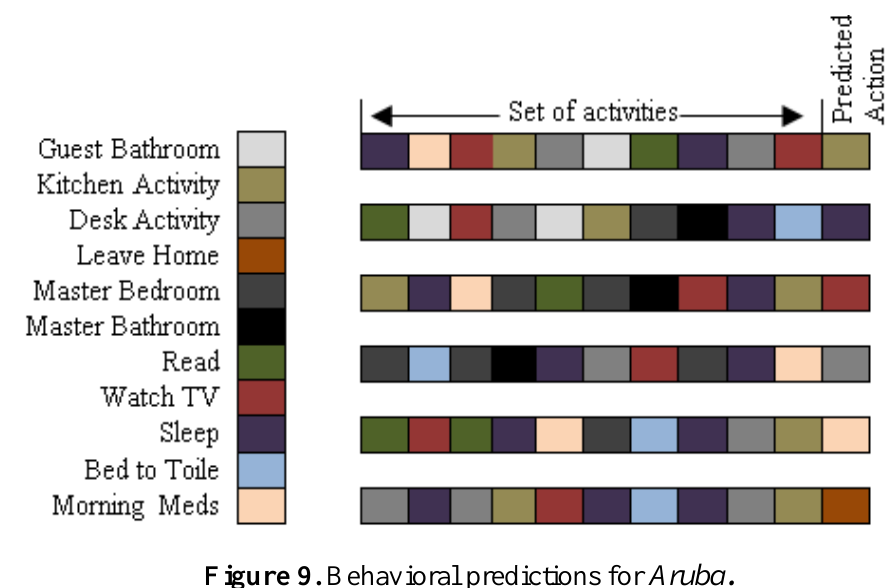
Figure 8. Behavioral predictions for Milan2009.